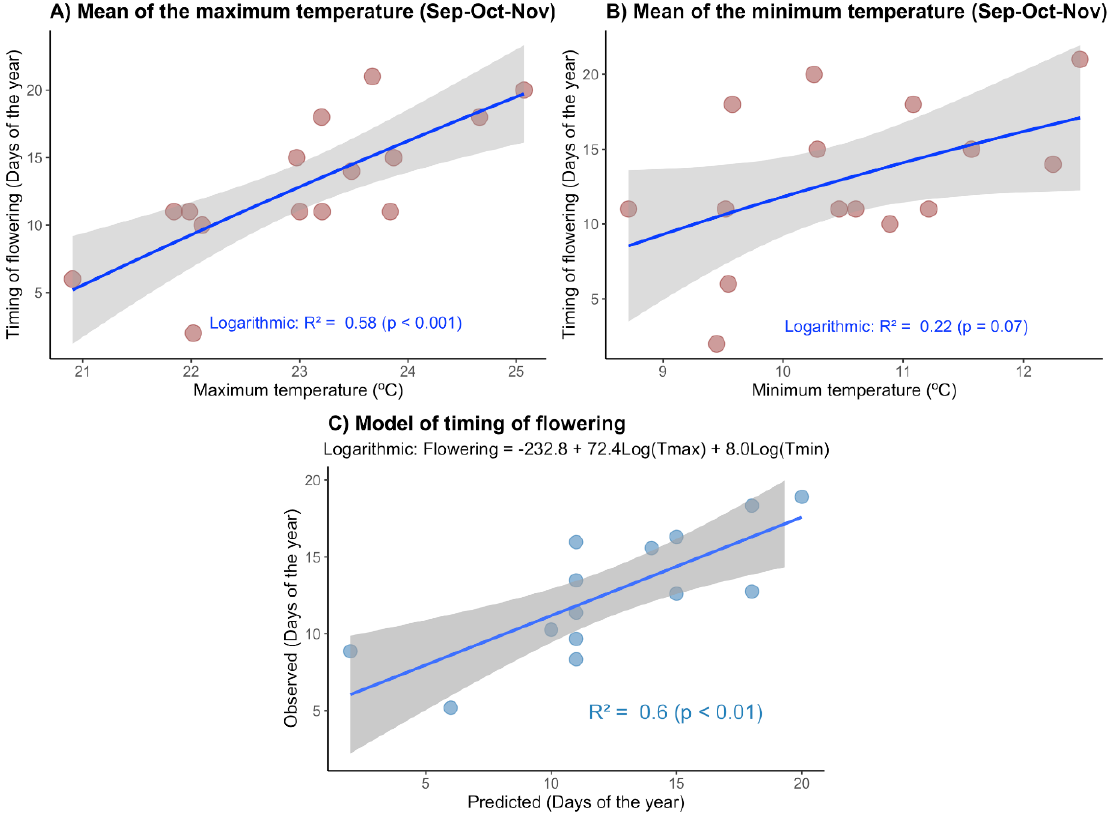
Figure 6. Relationship between the timing of flowering and average maximum and minimum temperatures during the autumn of the previous year (September-November) following a nonlinear model (logarithmic function). A, results of modeling the timing of flowering with mean maximum temperatures; B, results of modeling the timing of flowering with mean minimum temperatures; grey areas, 95% confidence interval; C, Non-linear (logarithmic function) models of alder